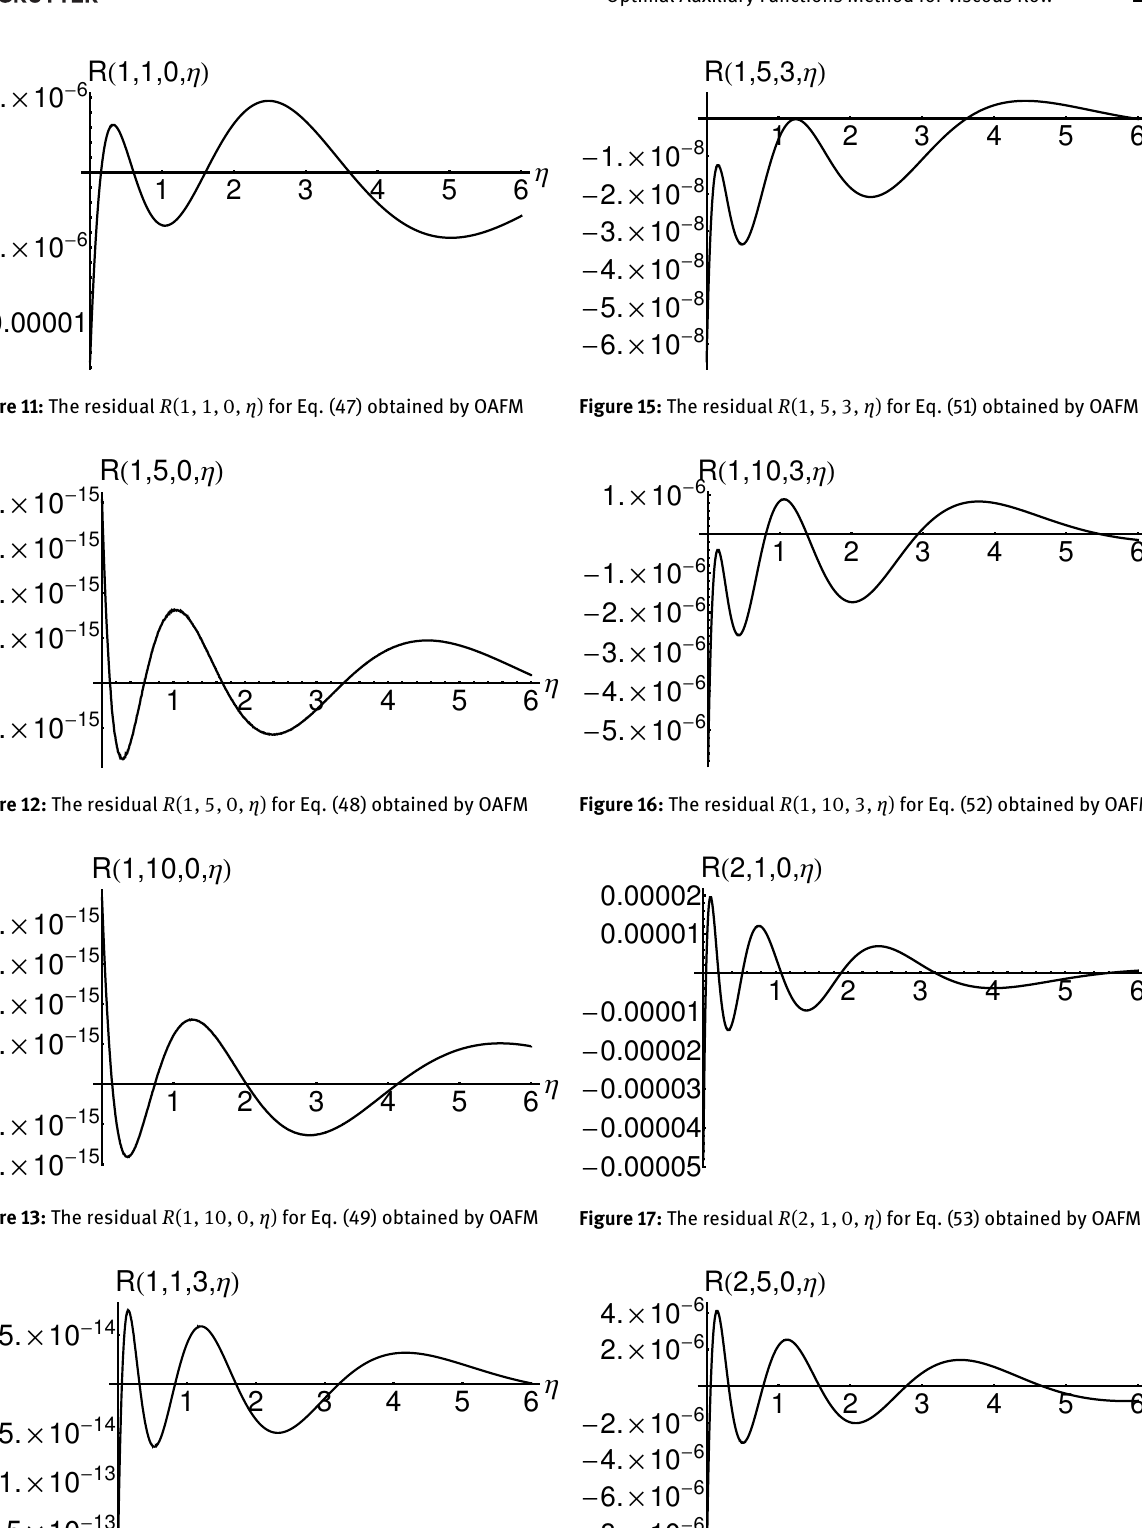
Figure 14: The residual R (1, 1, 3, η ) for Eq. (50) obtained by OAFM